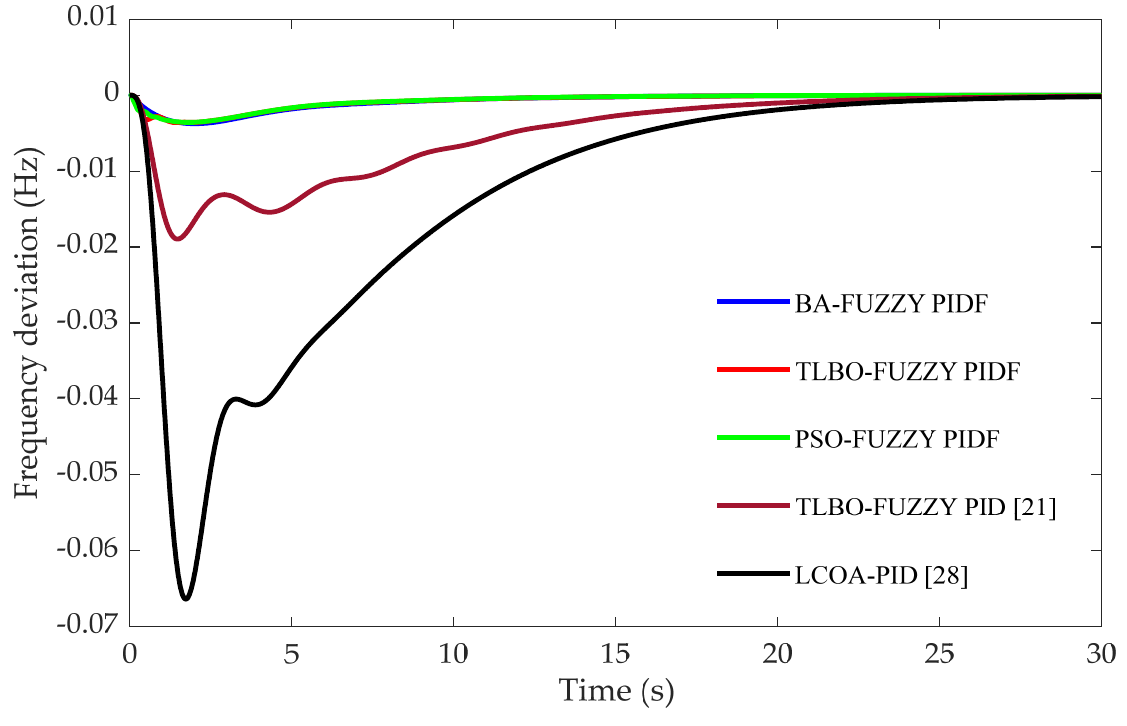
Figure 6. Frequency variation in area two ( ∆ F 2 in Hz).